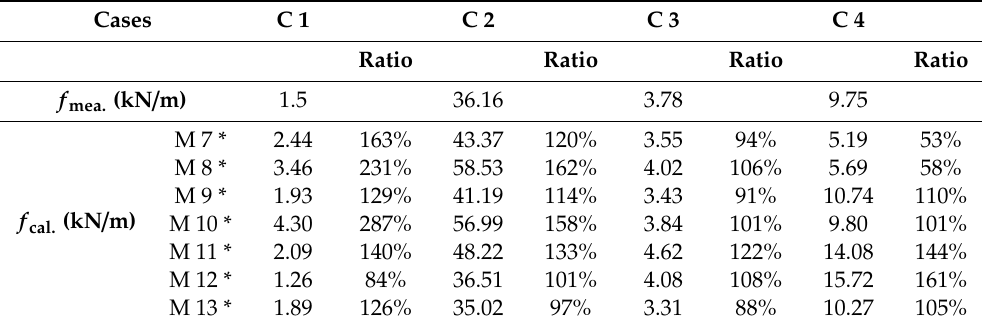
Table 6. Comparison of the friction resistances calculated by the new approach and the measured data. Cases C 1 C 2 C